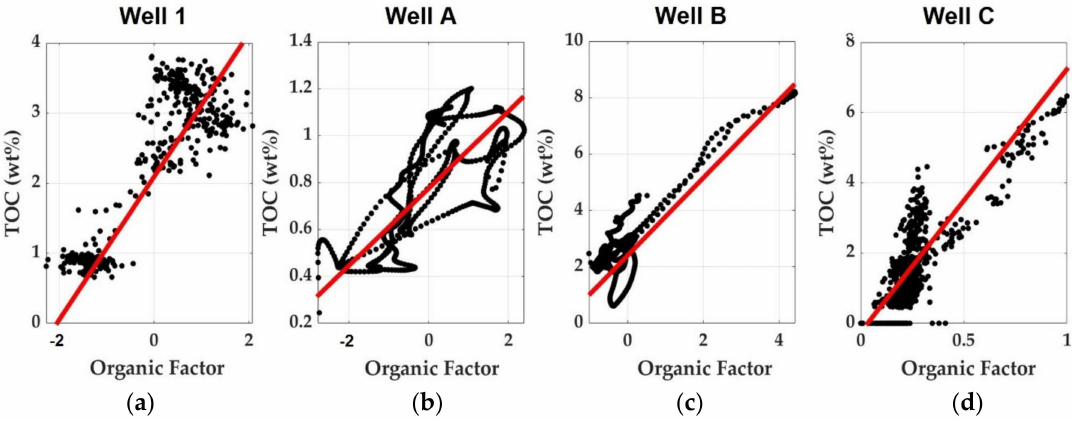
Figure 1. TOC vs. organic (second) factor regression plots: ( a ) synthetic modeling case (R = 0.87); ( b ) Pannonian Basin, Hungary (Well A) (R = 0.74); ( c ) Alaska, USA (Well B) (R = 0.88); ( d ) North Sea, Norway (Well C) (R =